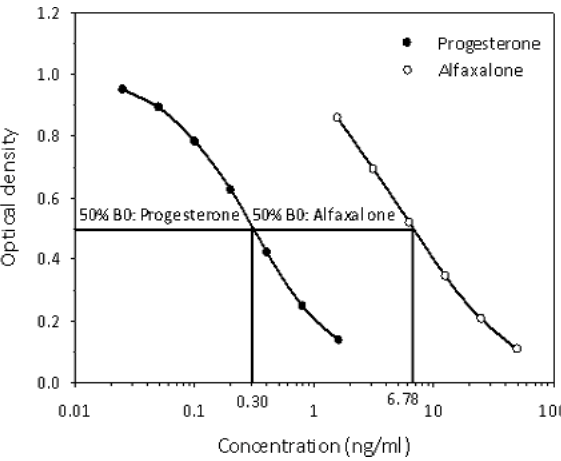
Figure 3. Cross-reactivity determination of alfaxalone measure- ment in the progesterone enzyme immunoassay used for analysis of serum progesterone concentrations of common marmosets. Con- centration values at 50% binding (50% B0) for progesterone and al- faxalone used for calculation of the alfaxalone cross-reactivity data are